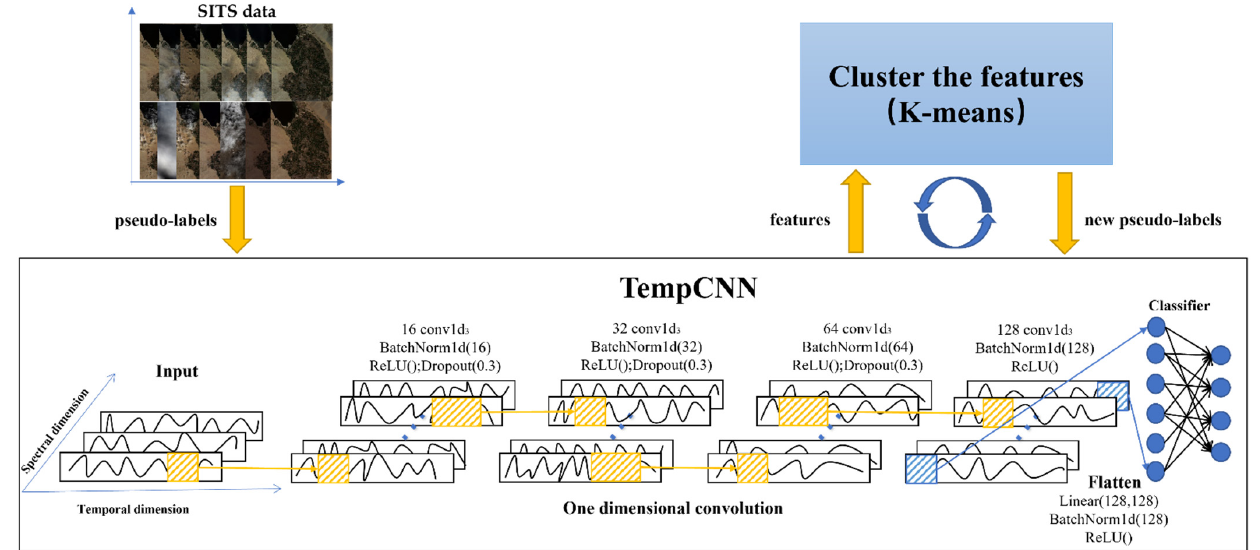
Figure 4. The overall framework of the proposed algorithm with the TempCNN feature extraction network.